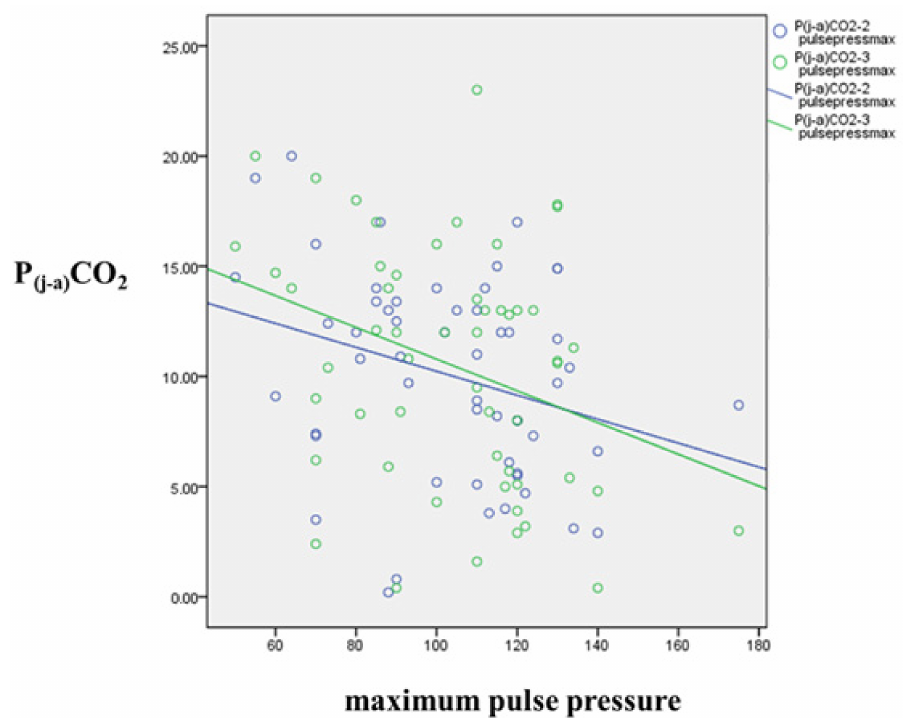
Figure 4. Correlation between maximum pulse pressure and P(j-a)CO 2 (mm Hg) during the carotid clamp. The circles represent the plotted values for each of the variables while the lines represent the best fit for the correlation between them. Blue line represents correlation of maximum pulse pressure and P(j-a)CO 2 after carotid clamp. Green line represents the correlation of maximum pulse pressure and P(j-a)CO 2 before release of